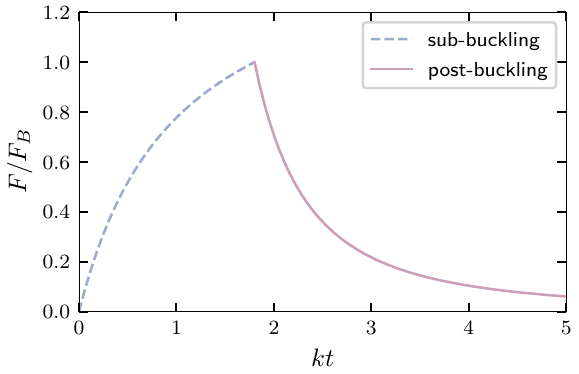
+ F 2 F 2 x y (rescaled by the buckling force (cid:31)